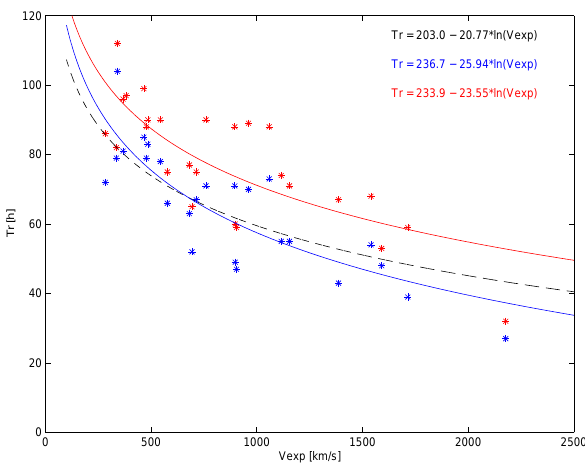
Fig. 8. Travel times for shocks (blue stars) and MC leading edges (red stars) vs. halo expansion speed. The black dashed line gives the least-squares fit for 75 CME-shock pairs in Schwenn et al. (2005). Blue and red lines give the least-squares fit for 26 CME-shock and CME-MC leading edge pairs in this